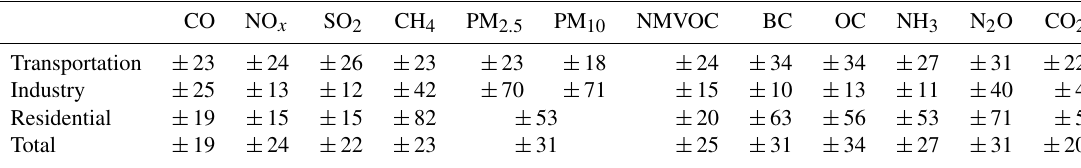
NA – not available. Table 18. Uncertainties (%) of emissions of three key sectors in